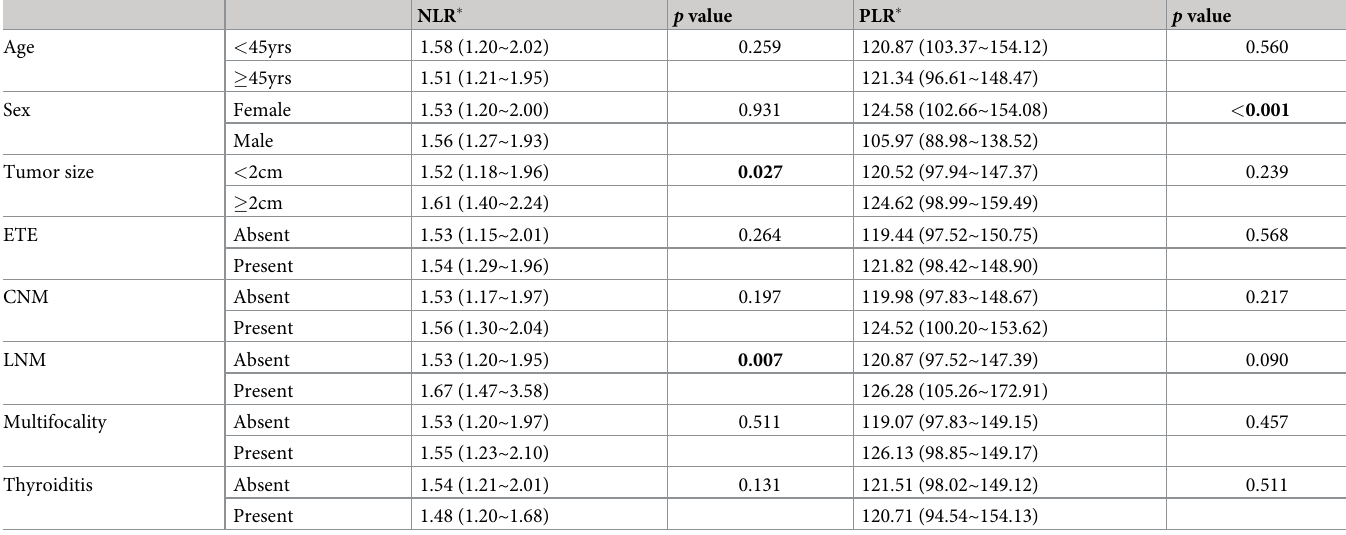
Table 2. Association between systemic inflammatory markers and clinicopathological characteristics in thyroid cancers.